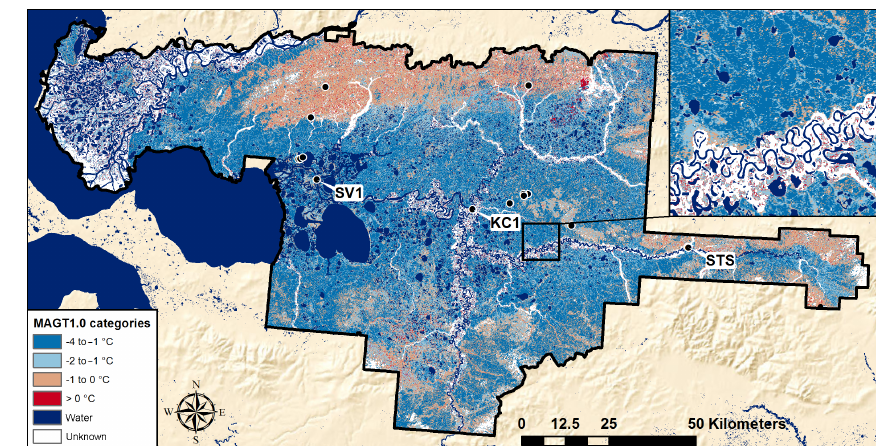
Figure 12. Map of MAGT at 1m depth for the SNWR using only ecotypes for which we made measurements.